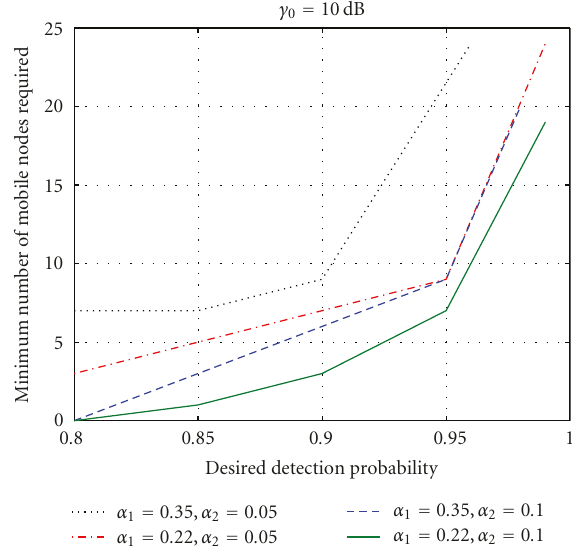
Figure 11: Minimum number of mobile nodes required to achieve a desired performance level; (cid:2) 1 = 0, (cid:2) 2 = 0; T s = 1s, v = 1m/s, p k = p = 0, γ 0 = 10dB, T D = 20s target is assumed to be located at (0,0)